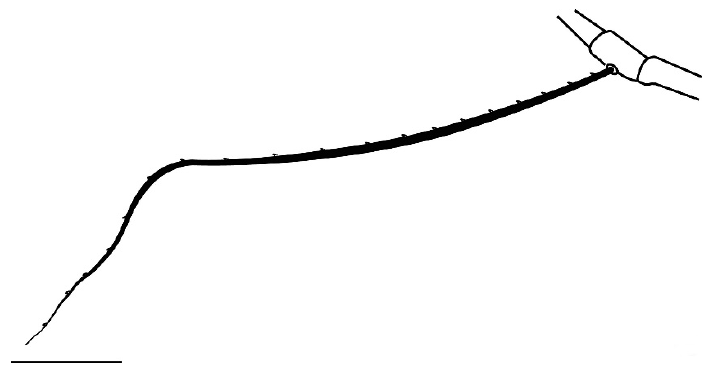
Figure 15. Neophyllobius fissus . Female. Genu II. Scale bar: 50 μ m.